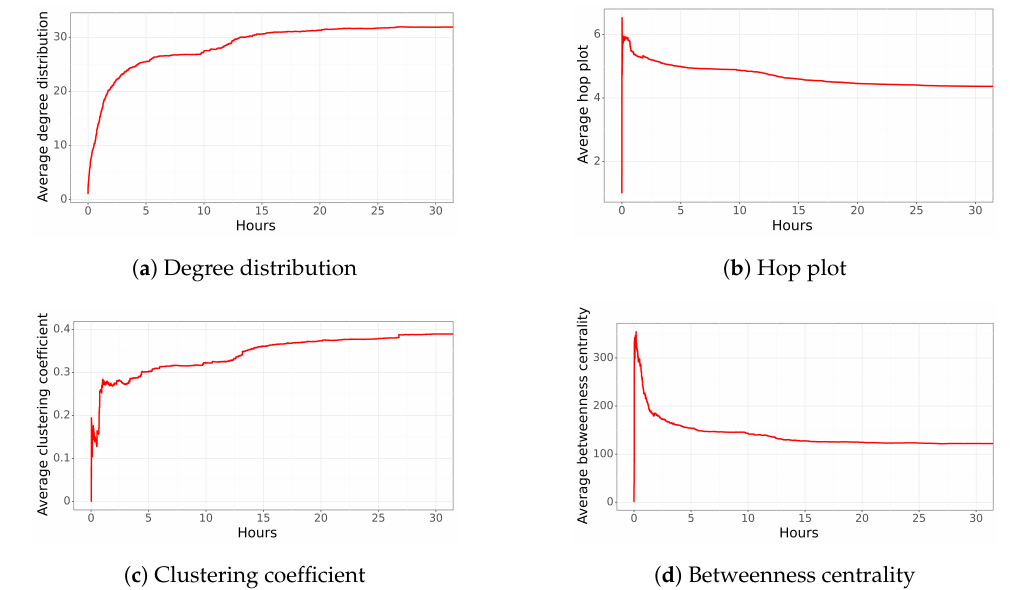
Figure 4. Average network characteristics for the interview network tendency over time. The X-axes of these plots are reduced from 1 week to 30 h to improve